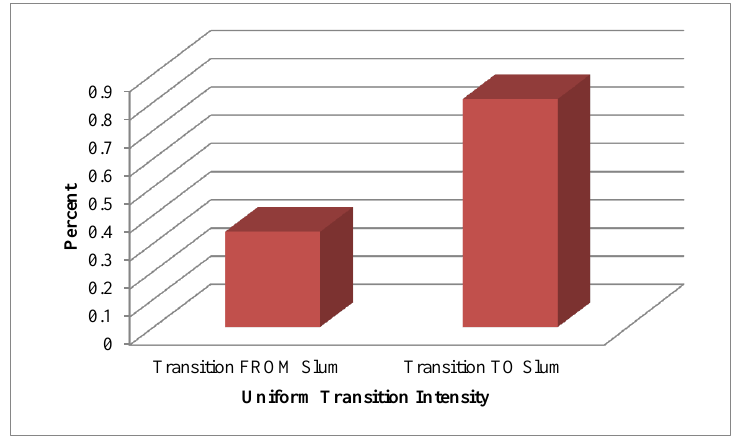
Figure 12. Comparison of uniform transition intensity of slum in the time interval.